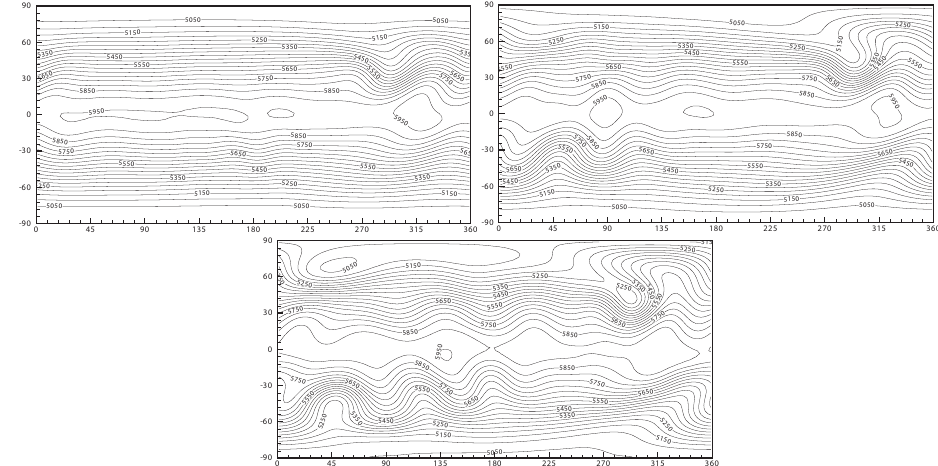
Figure 9. Numerical results of total height field for case 5 on grid G 12 at day 5 (top left), day 10 (top right) and day 15 (bottom).